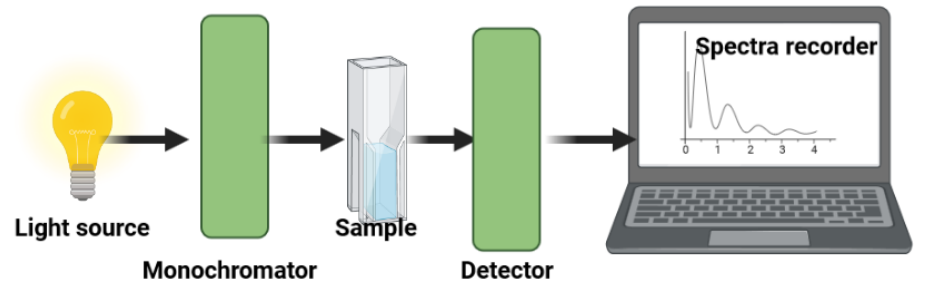
Figure 4. UV-Vis measurement principle (Created in